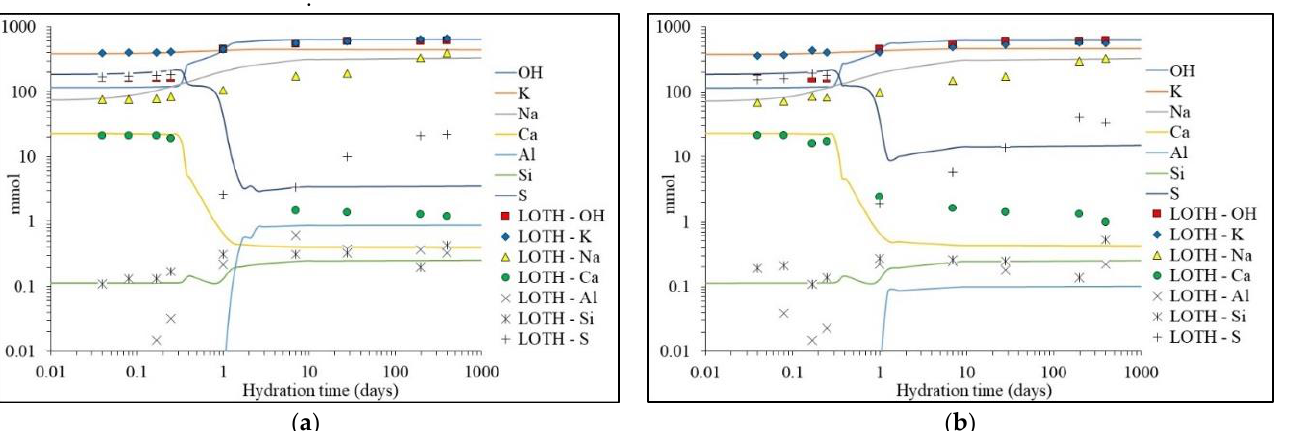
Figure 5. Pore solution chemistry produced by the PHREEQC model using [20] for ( a ) OPC and ( b ) 4% limestone binder (LOTH represents the measured data from [20]). ( a ) OPC pore chemistry; ( b ) 4% limestone pore chemistry.